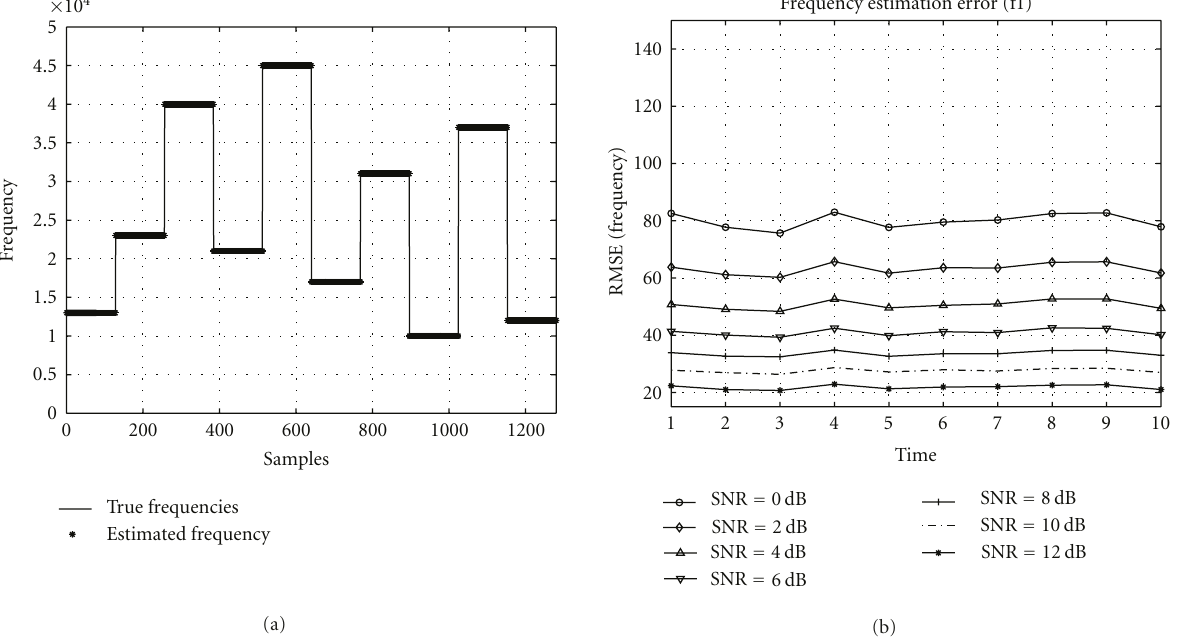
Figure 7: Root mean square estimation error versus tracking frequency with initial K = random . (a) Frequency tracking and (b) RMSE of frequency